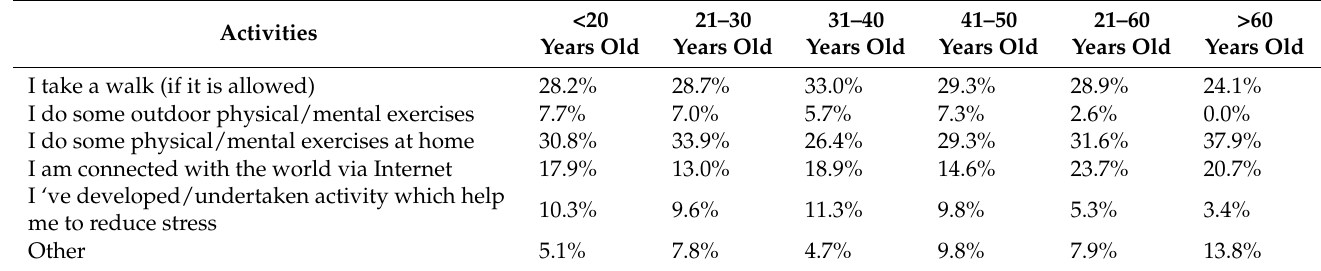
Table 2. Activities to cope with COVID restrictions according to the age of respondents ( n =